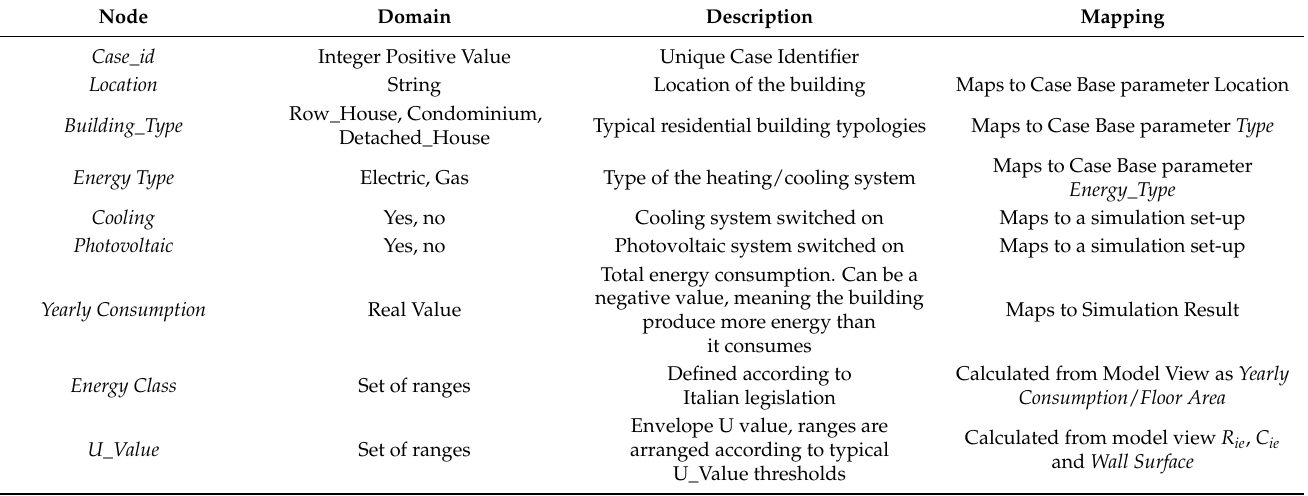
Figure 11. The Bayesian Network that implements the thermal index–frame. Table 3. The specification of the nodes in the Thermal Index